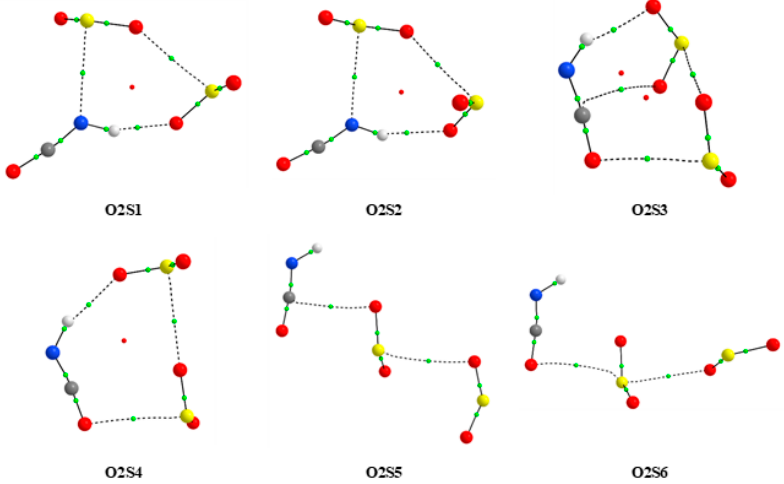
Figure 2. The MP2 optimized structures of the 1:2 complexes of HNCO with SO 2 . Table 3. BSSE-corrected interaction energies E int , relative energies Δ E, relative Gibbs free energies Δ G (kJ mol − 1 ) and dipole moments μ (Debye) of the HNCO…SO 2 complexes of the 1:2 stoichiometry calculated at MP2, B3LYPD3 and B2PLYPD3 levels.